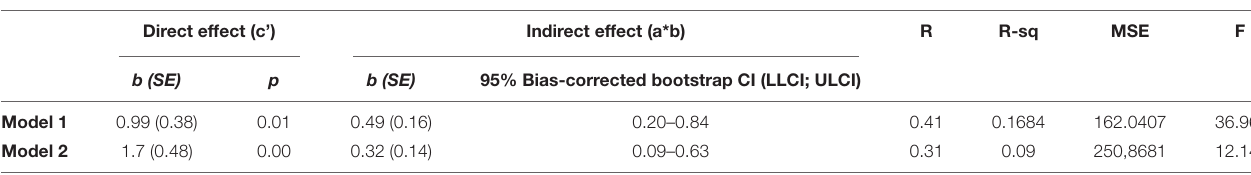
FIGURE 1 | The mediation analysis model including education, leisure attitude, and psychological well-being. TABLE 2 | Model coefficients for the conditional process models presented in Figures 1 , 2